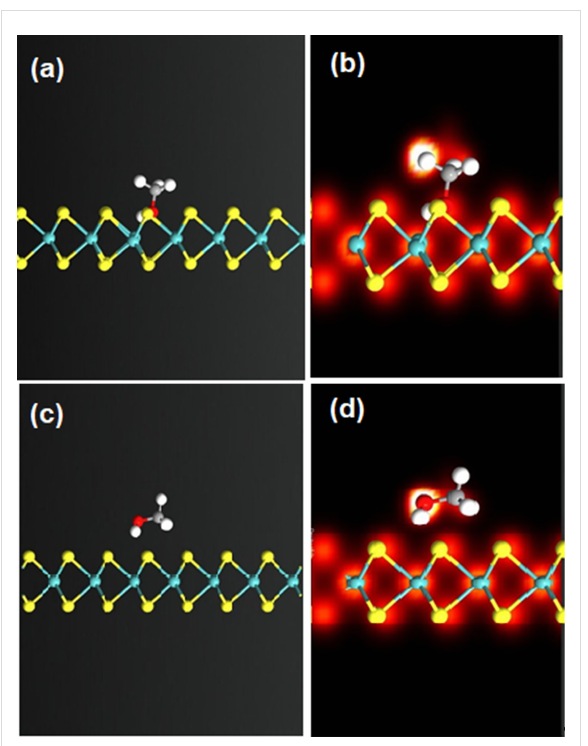
Figure 7: The optimized structure of methanol on (a) defect-contain- ing MoS 2 . (b) The corresponding electron density of methanol on defect-containing MoS 2 . (c) The relaxed structure of methanol on pris- tine MoS 2 . (d) The electron density of methanol on pristine MoS 2